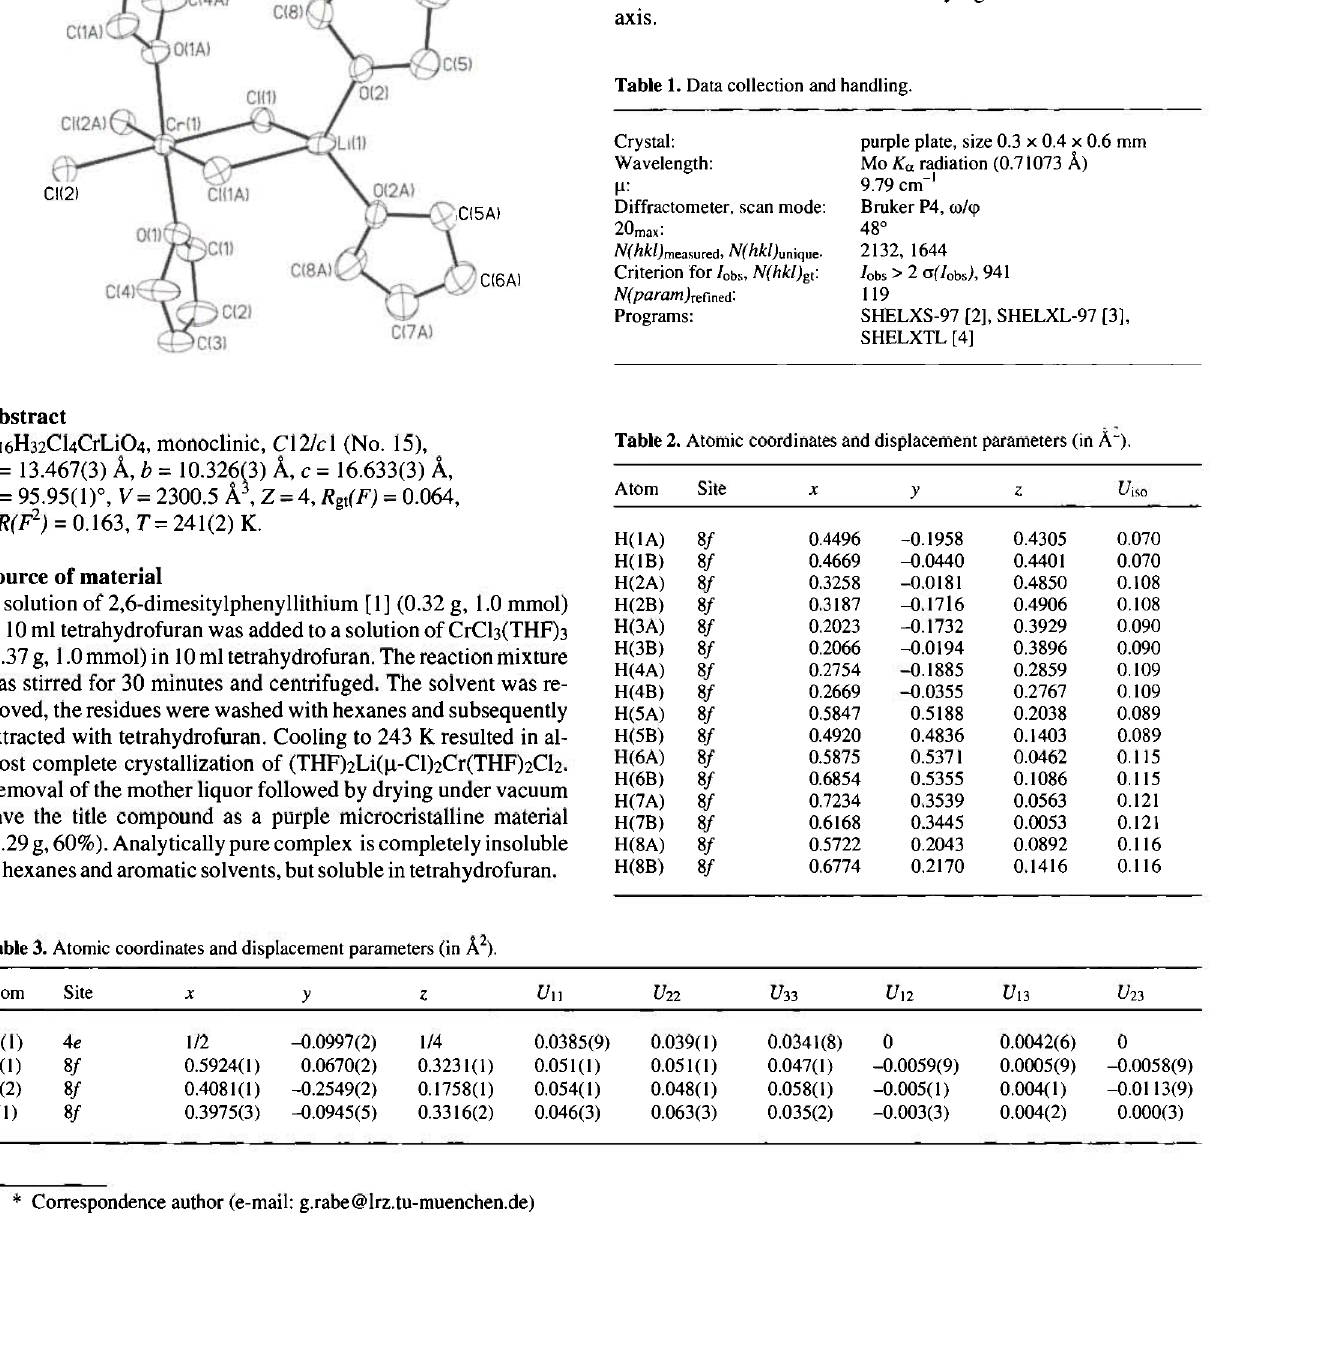
Table 1. Data collection and handling.